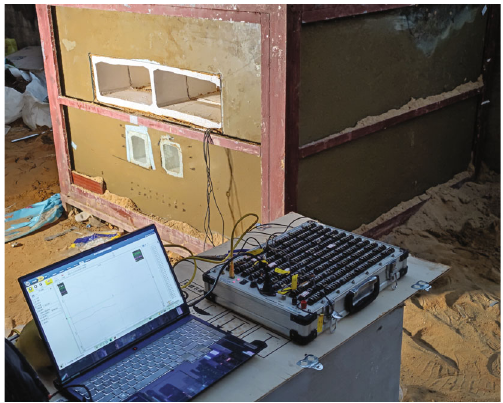
Figure 7: Dynamic signal acquisition and analysis